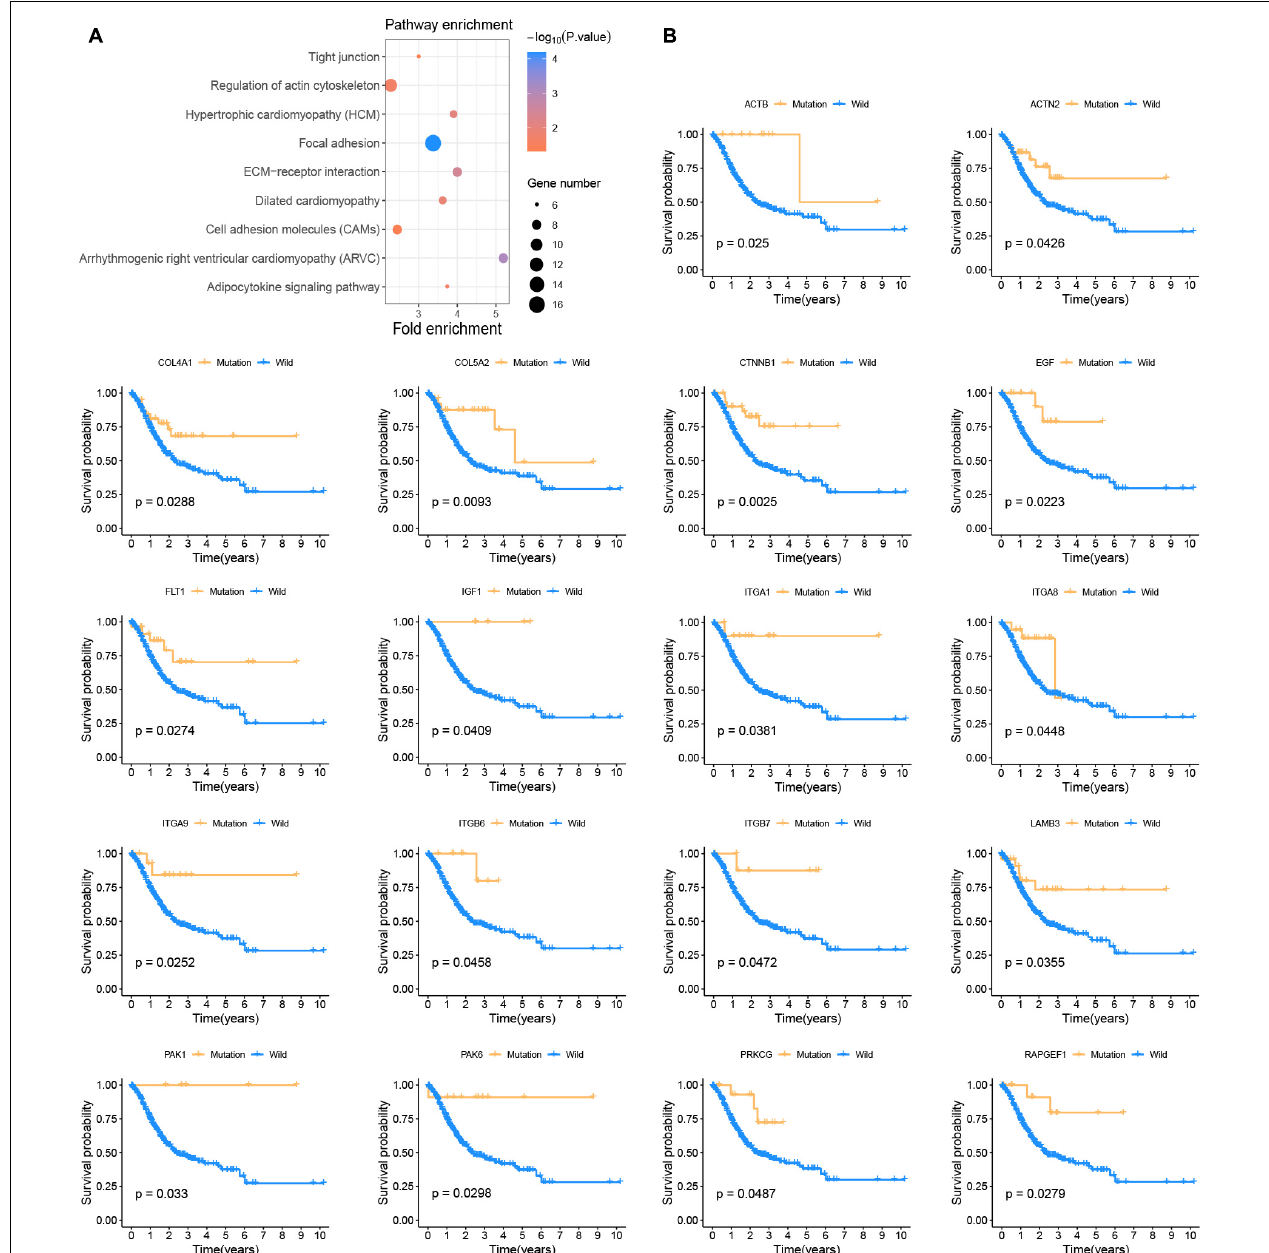
FIGURE 2 | Somatic mutations affect the prognosis of patients with GC (A) KEGG enrichment analysis of prognostic-related somatic mutation genes. (B) Kaplan-Meier survival curve of 18 focal adhesion pathway-related